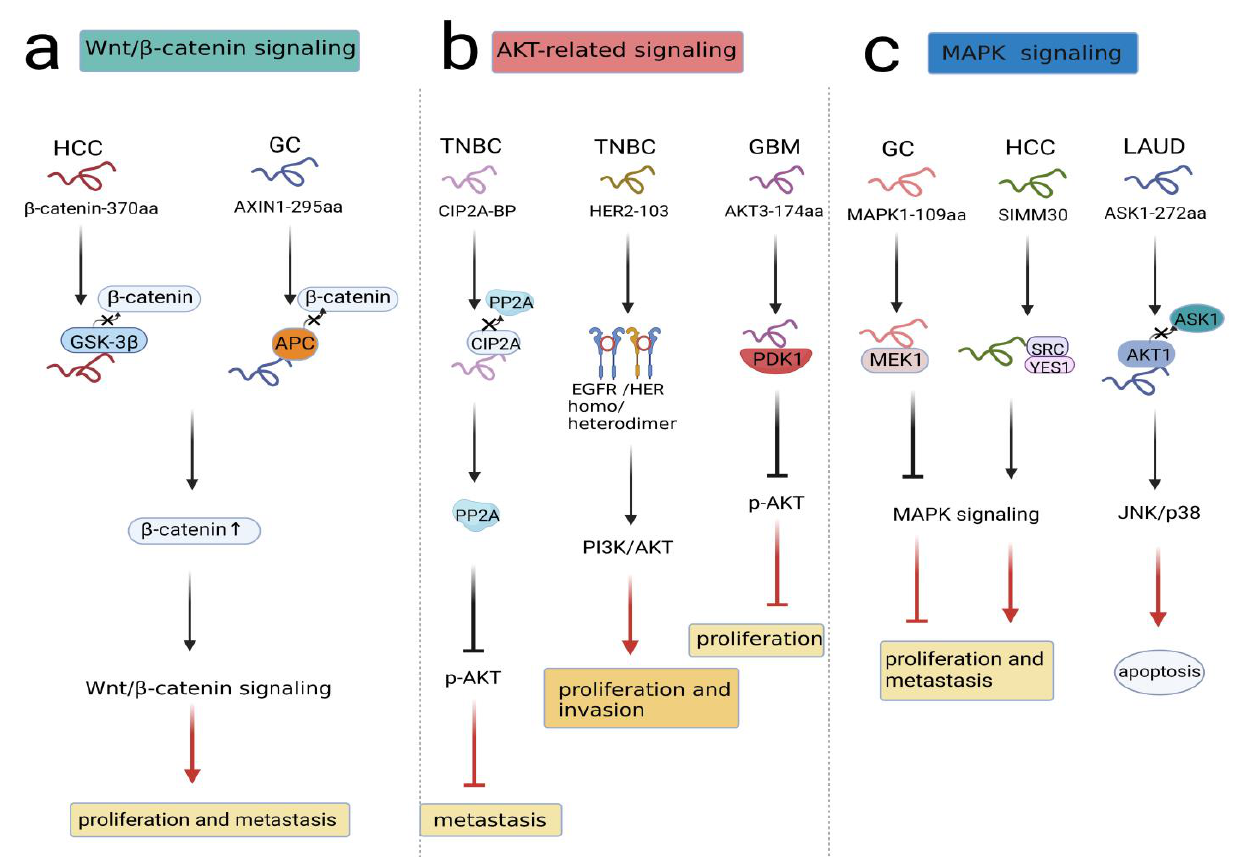
Figure 2. NcRNA-encoded peptides/proteins regulated signal transduction. ( a ) β -Catenin-370aa and AXIN1-295aa competitively bound to component(GSK- 3β, APC) in destruction complex to activate Wnt/β -catenin pathway, promoting proliferation and metastasis in HCC and GC. ( b ) CIP2A-BP competitively bound to CIP2A, prohibiting p-AKT and TNBC metastasis; HER2-103 induced EGFR/HER3 homo/heterodimer formation and downregulated PI3K/AKT activation, promoting